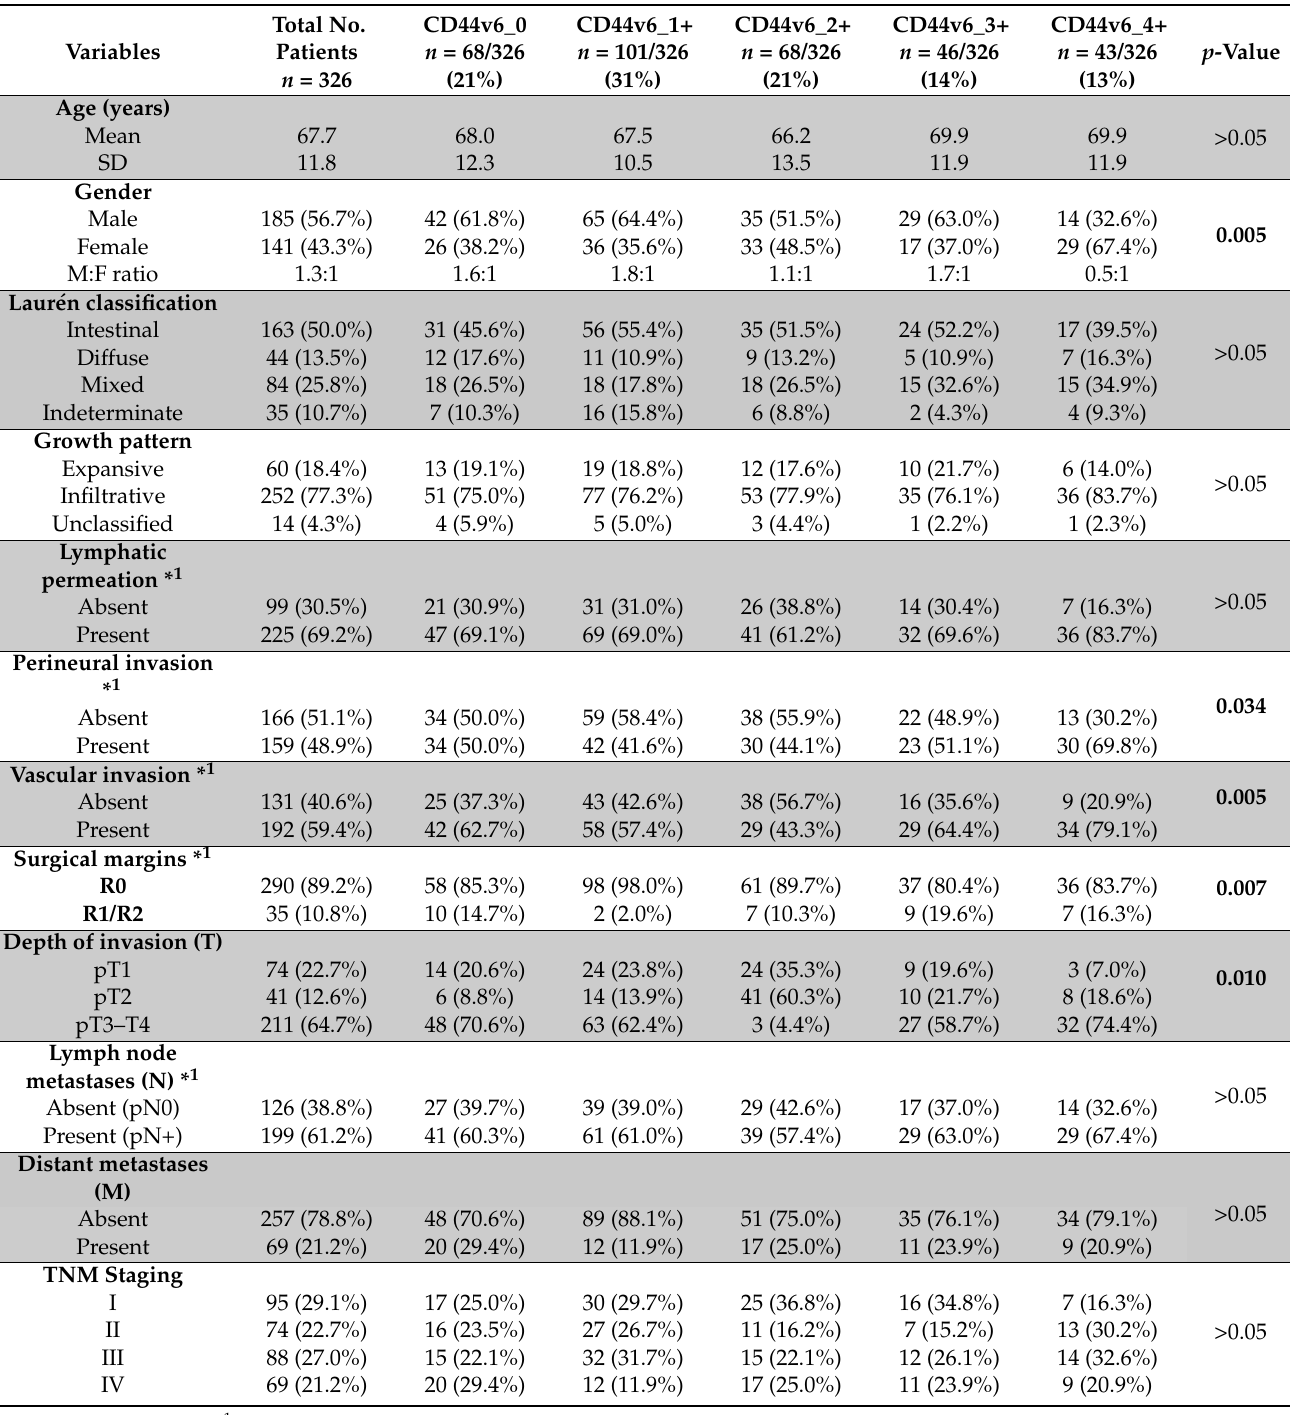
Table 1. Clinicopathological associations with extent of CD44v6 expression in gastric tumors from the CHUSJ cohort. Total Variables